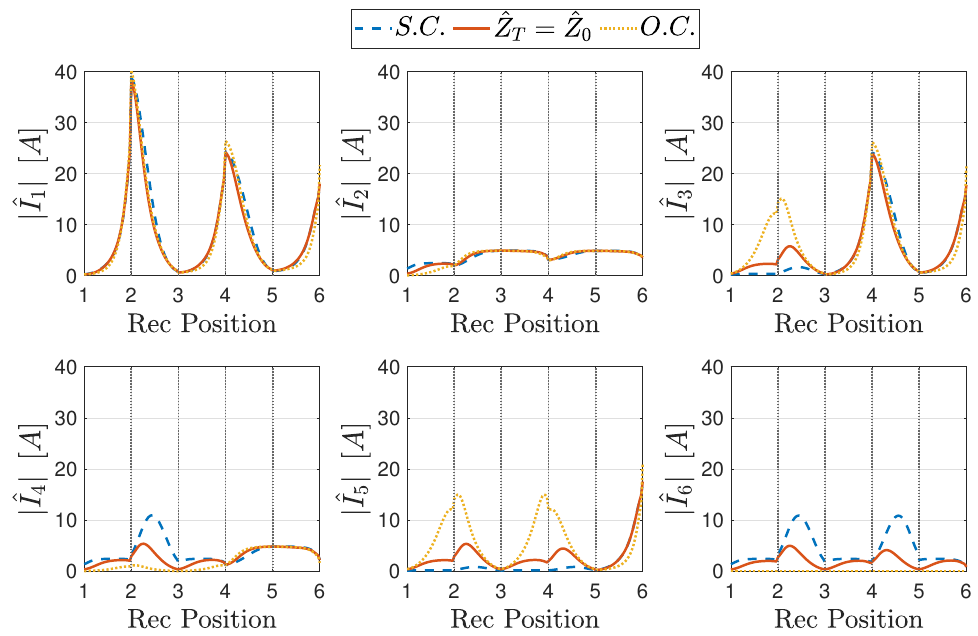
Figure 14. Magnitude of the currents of the array resonators as a function of the receiver position, for different terminations and a receiver load ˆ Z load = 0.7 Ω .